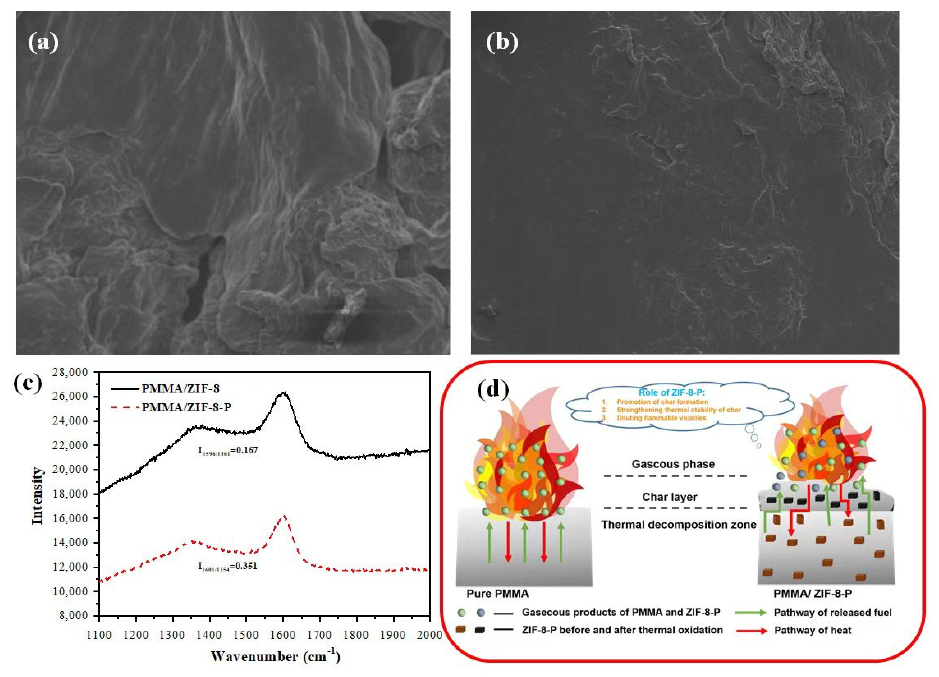
Figure 4. SEM of the char, including the ( a ) PMMA/ZIF-8 and ( b ) PMMA/ZIF-8-P composites. ( c ) Raman spectra for the carbon residue of the PMMA/ZIF-8 and PMMA/ZIF-8-P composites. ( d ) Schematic diagram of improving the flame retardance of the PMMA/ZIF-8-P composite.